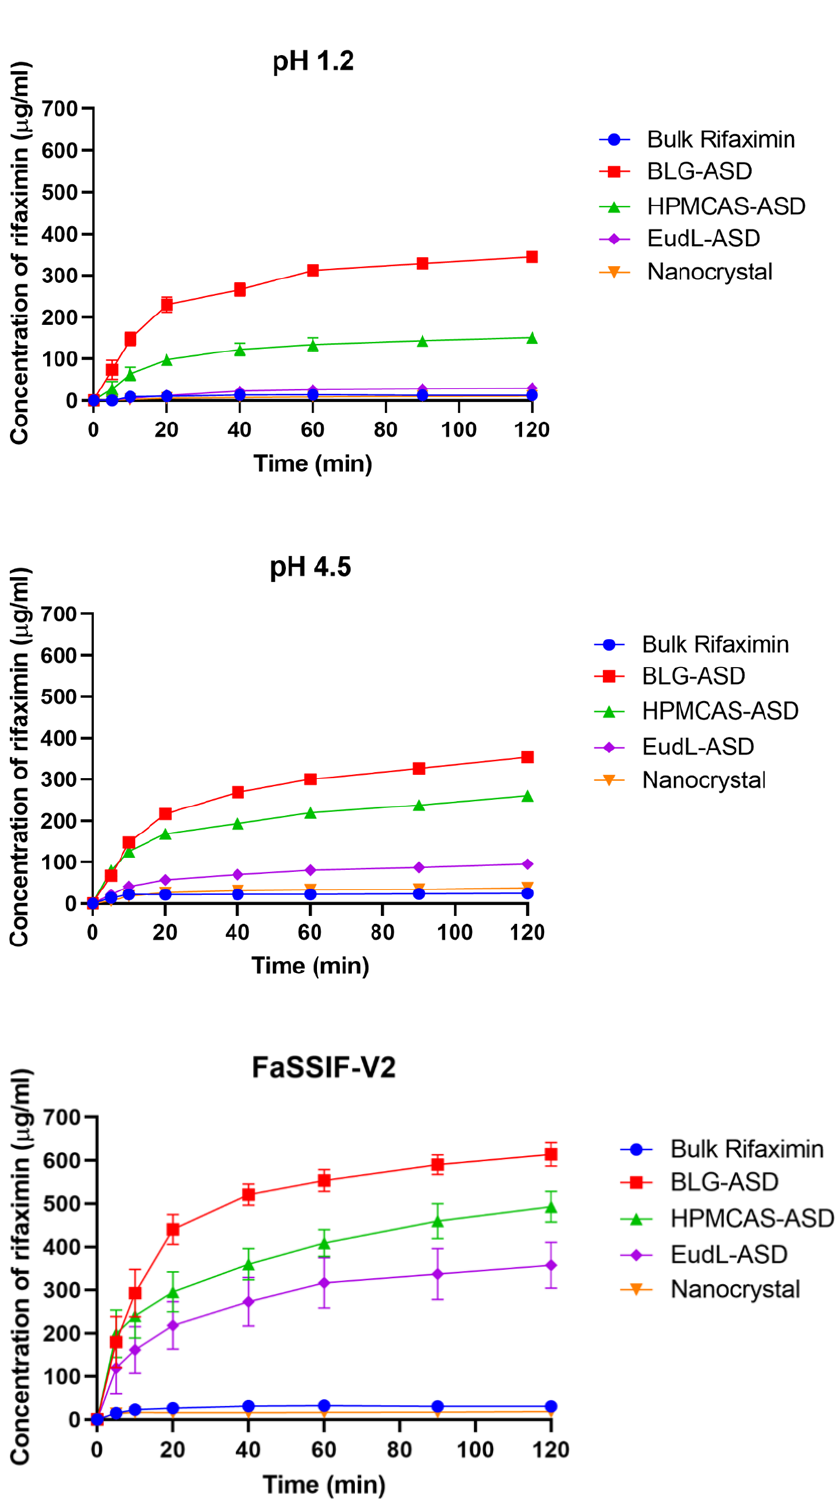
Figure 4. In vitro powder dissolution profiles of bulk RFX and the freshly prepared samples, in pH pH 1.2, pH 4.5, and 1.2, pH 4.5, and FaSSIF-V2.